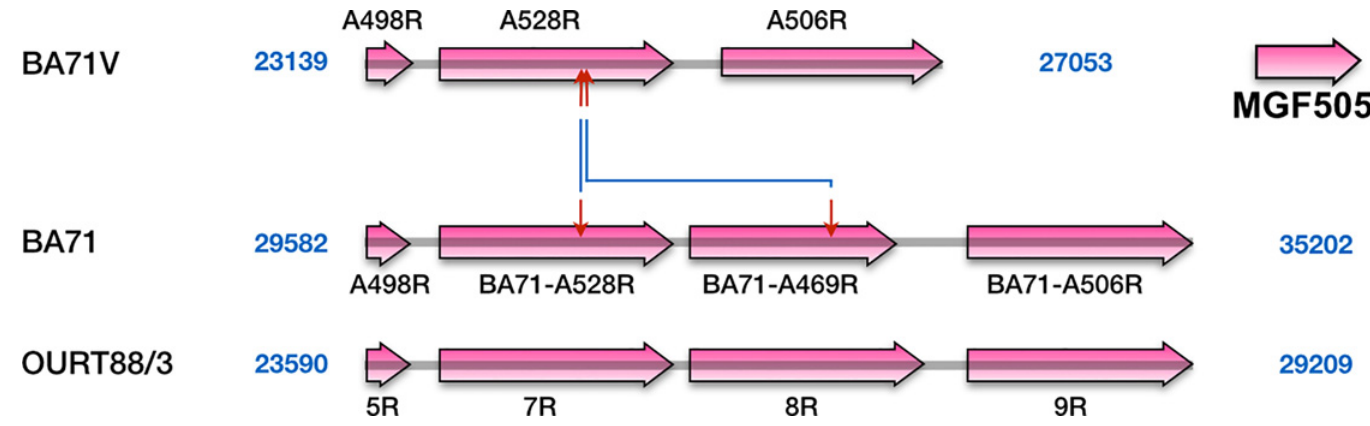
Fig 5. Comparison of the genomic structure of BA71 with BA71V and OURT88/3 around difference 17. The figure shows a representation to scale of the genomes of BA71, BA71V and OURT88/3 around the position of BA71-BA71V difference 17 (the exact positions are indicated for each of the genomes). Red arrows delimit non-identical regions. Blue lines connect arrows at equivalent positions. The ORFs are members of MGF 505.